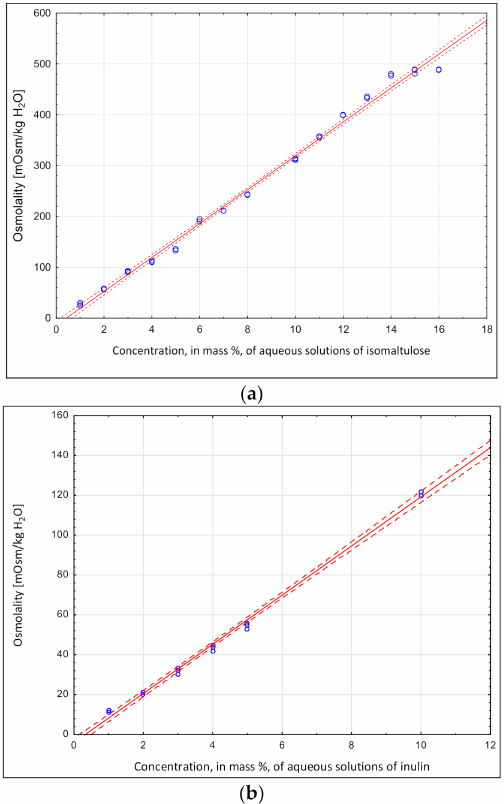
Figure 2. Isomaltulose. ( a ) Osmolality = − 14.19 + 33.35 × Concentration; r 2 = 0.996 and inulin. ( b ) Osmolalities in aqueous solution: Osmolality = − 14.19 + 33.35 × Concentration; r 2 =